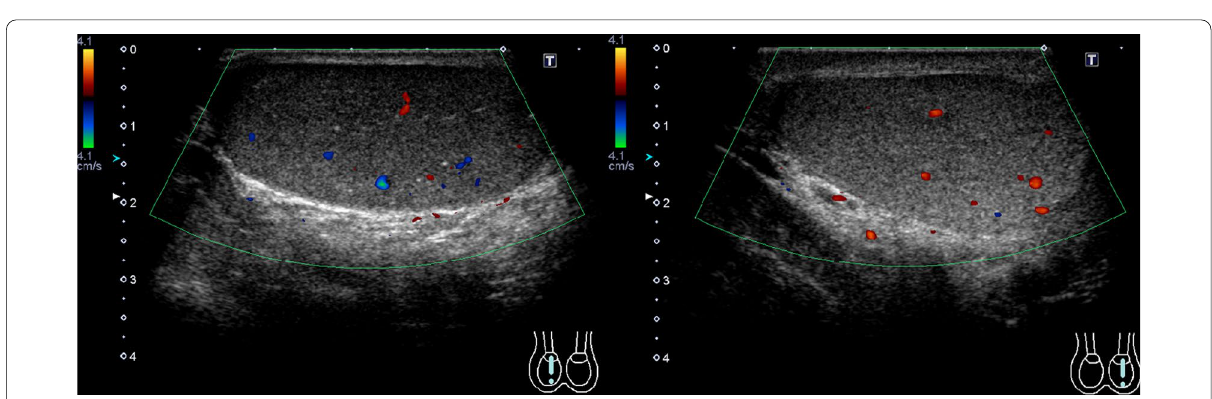
Fig. 3 Ultrasound findings after 6 months from the operation. Six months after operation, surface ultrasound scan of the scrotum showed